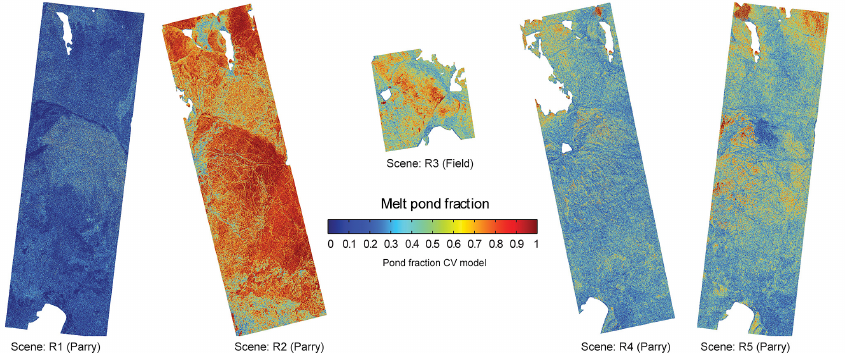
Figure 6. Retrieved pond fraction using the CV model. Refer to Fig. 1 for scale and location information, and Table 1 for scene infor- mation. White features within scenes correspond to areas of land that have been masked out. Original Radarsat-2 data © MacDONALD, DETTWILER AND ASSOCIATES LTD., 2012 All Rights